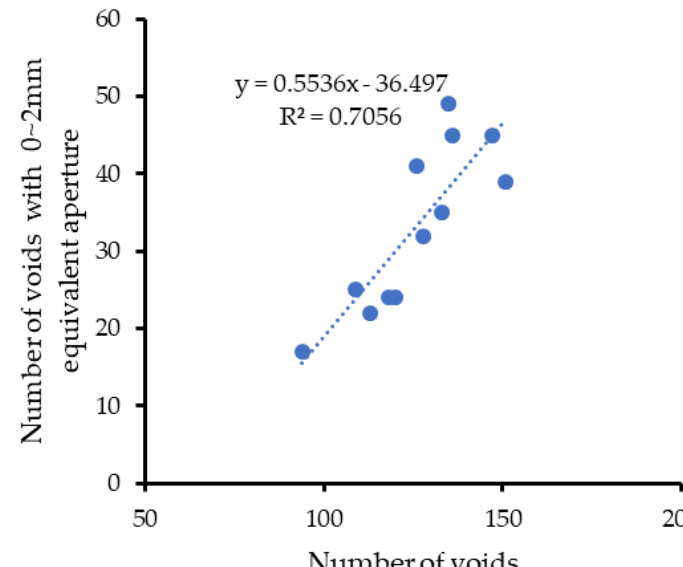
Figure 11. Voids number distribution along the horizontal section.